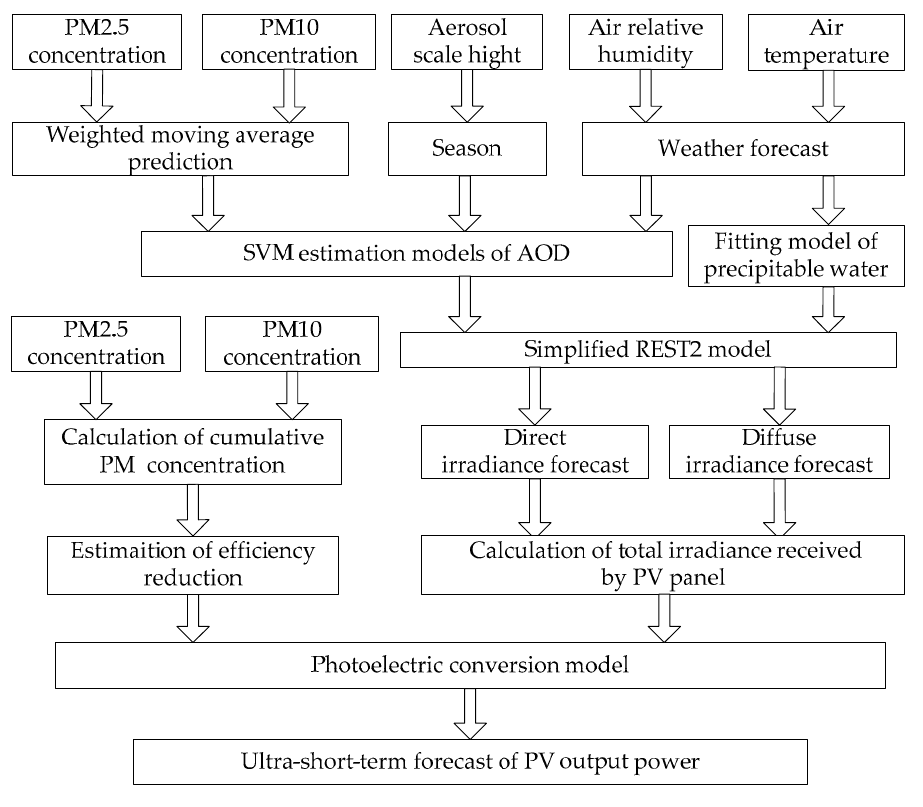
Figure 13. Flow chart of the presented forecast method.